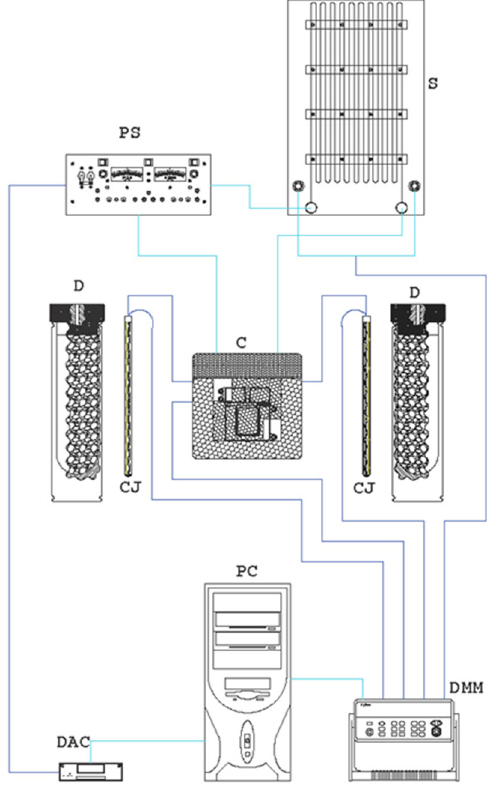
Figure 3. Experimental thermal conductivity setup.